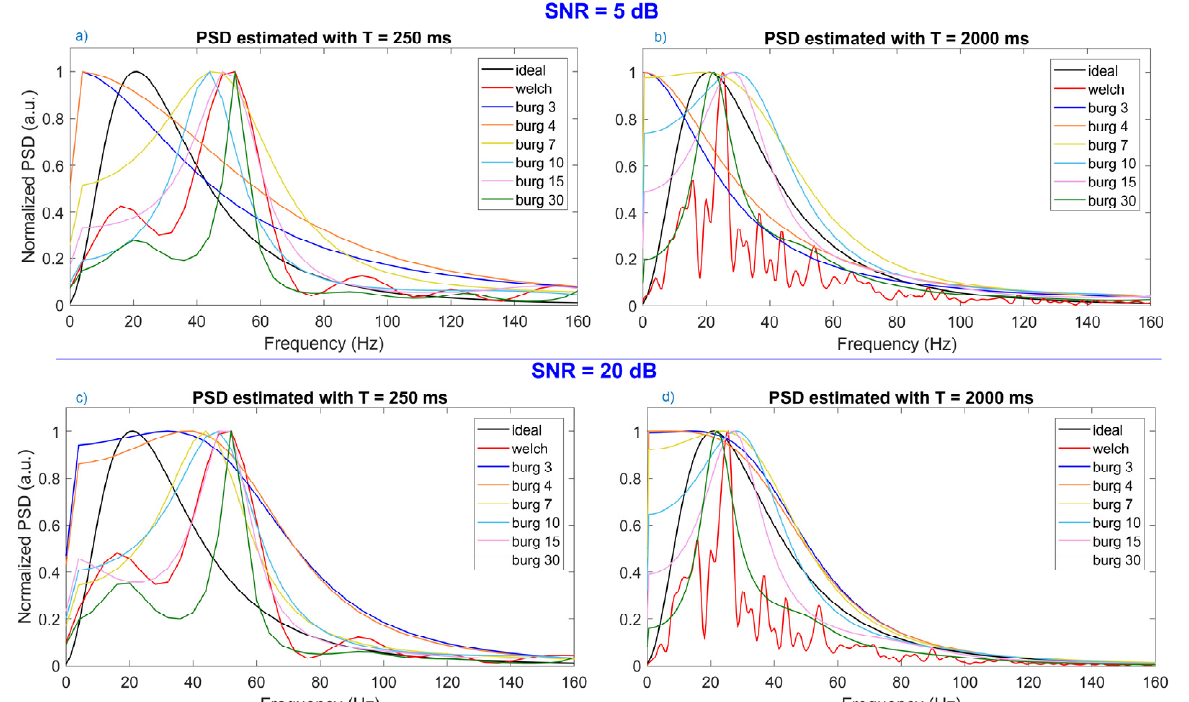
Figure 1. Representation of the ideal Power Spectral Density (PSD) together with power spectra estimated with Welch method and six different orders of the Burg method. ( a , b ) show the spectra estimated from signals whose Time duration (T) is equal to 250 and 2000 ms, respectively. These two figures were generated when Signal-to-Noise-Ratio (SNR) was low, that means there was a high level of noise. In the same way, in ( c , d ) power spectral densities, which were extracted from signals with time duration equal to 250 and 2000 ms, respectively, can be seen, but the SNR of signals was high, that is there was a low level of noise.